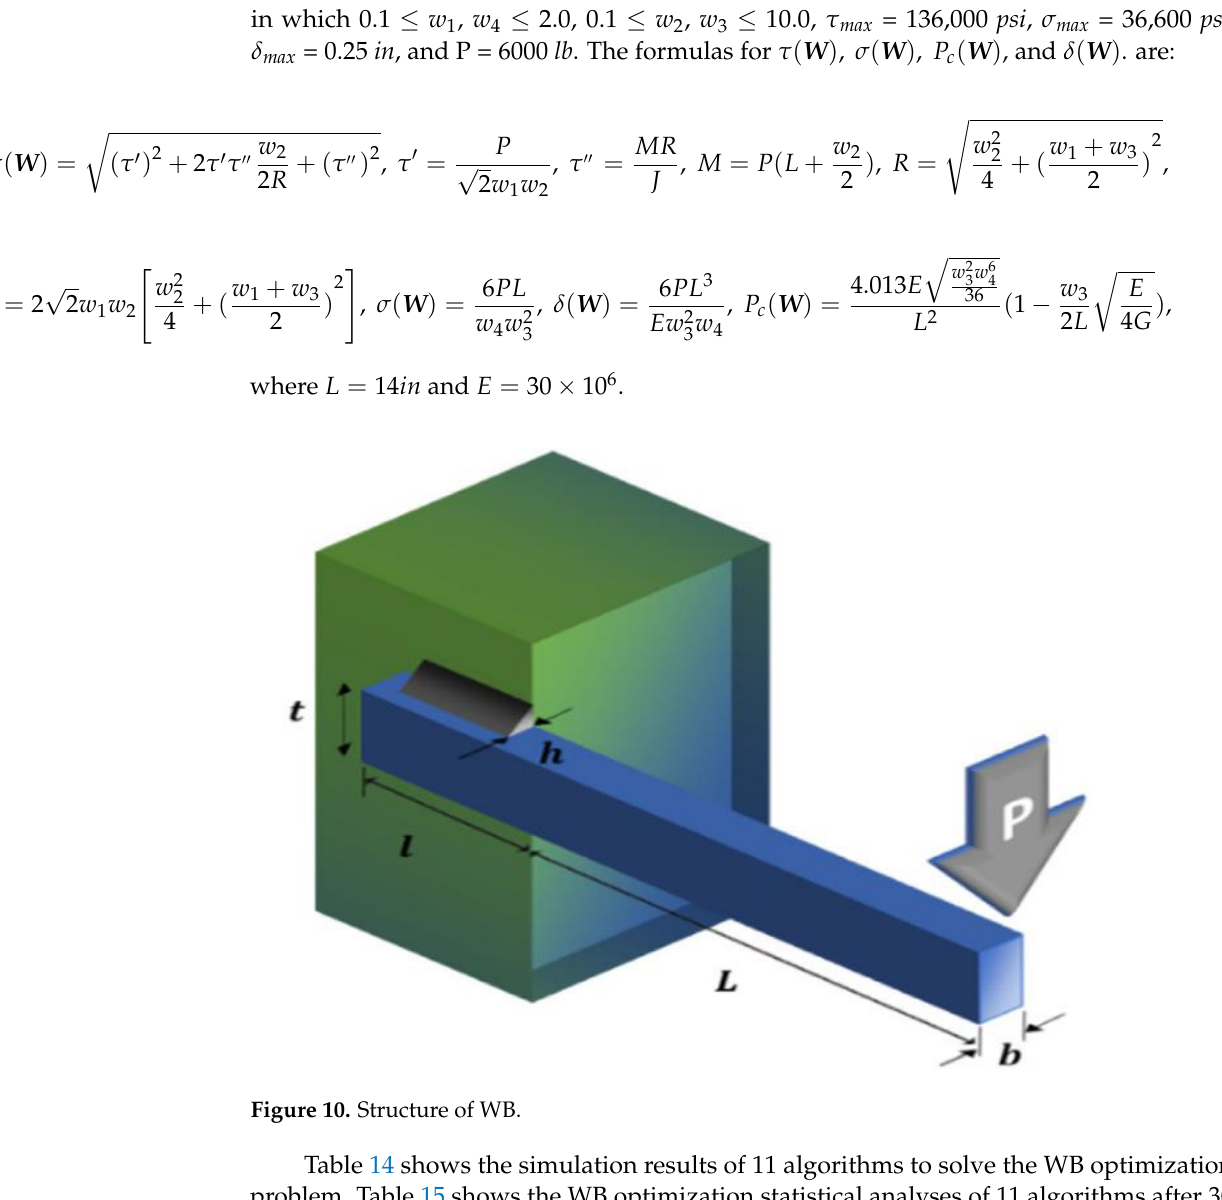
Table 14. Results of all 11 algorithms.